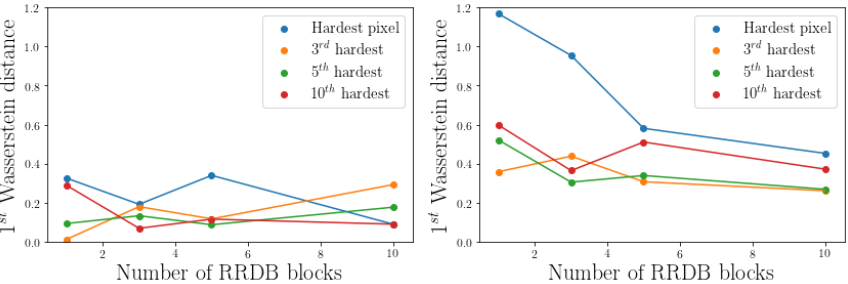
Figure 11: Dependence of the performance of super resolution networks on the num- ber of internal RRDB blocks (See Fig. 2). Performance is measured via the one di- mensional Wasserstein distance between the distribution of quantities over true high- resolution images and the super-resolution images. Quantities examined are the en- ergy of the leading pixel, subleading, etc. Left (right) shows results for networks trained on top-quark (QCD) jets and applied to top-quark (QCD)